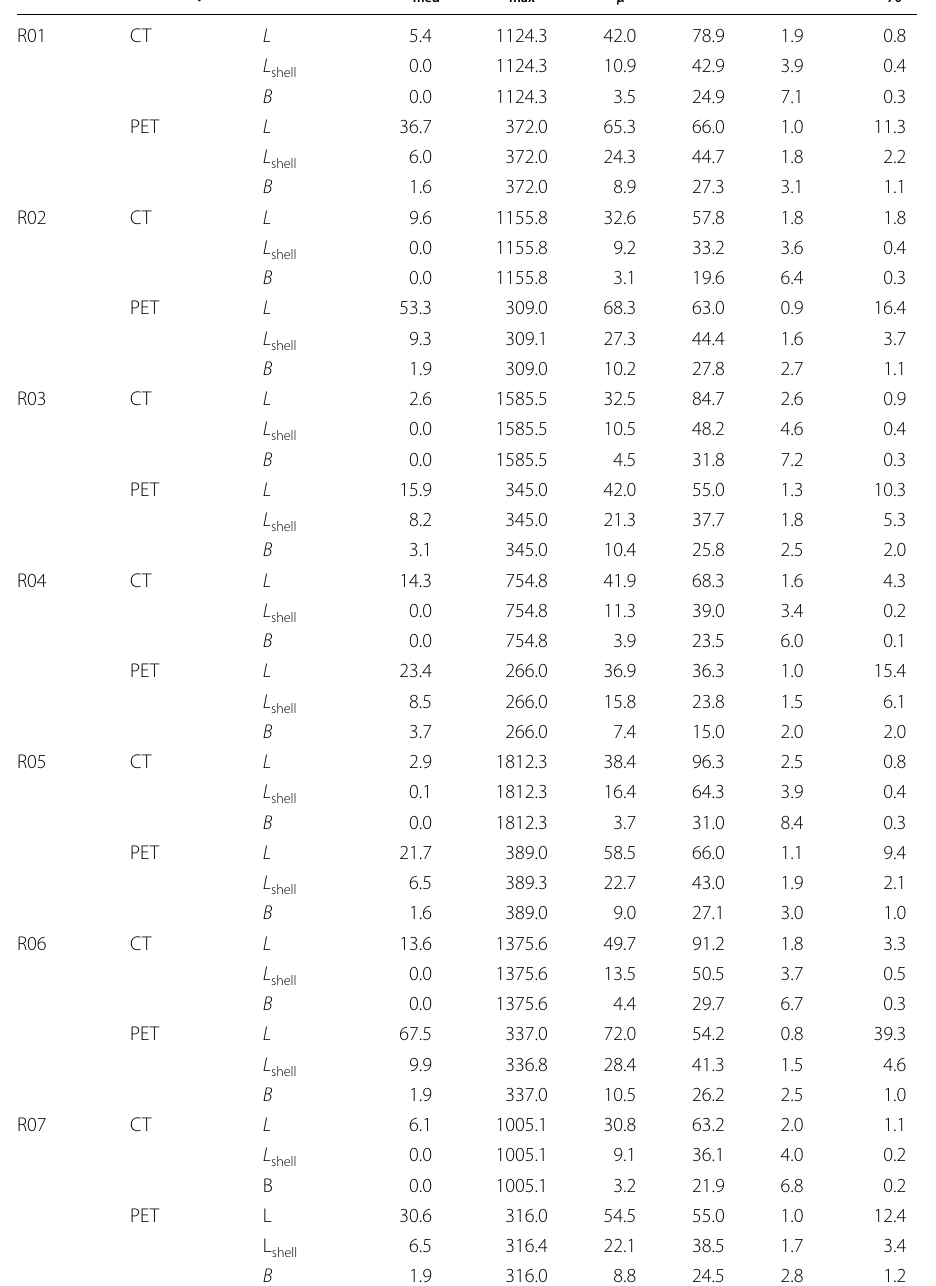
Table 3 Dose metrics for all structures within the CT-based dose distribution DD CT and the PET- based dose distribution DD PET across all rabbits. All values are in units of Gy except for the unitless COV Rabbit